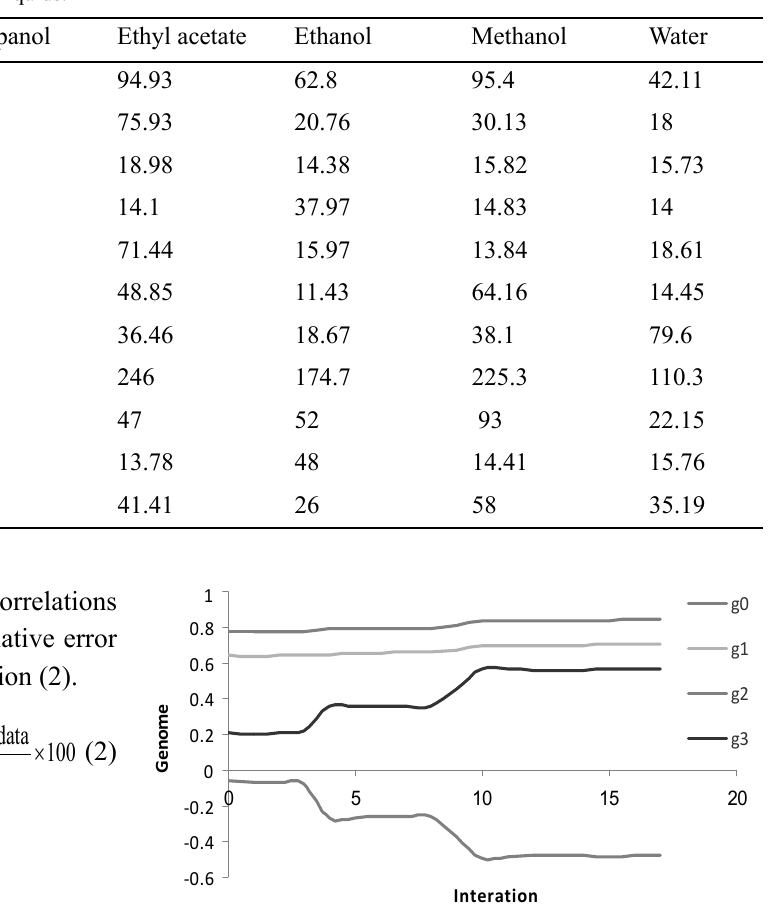
Fig. 4. Gene convergence of the genetic algorithm with optimal reply.